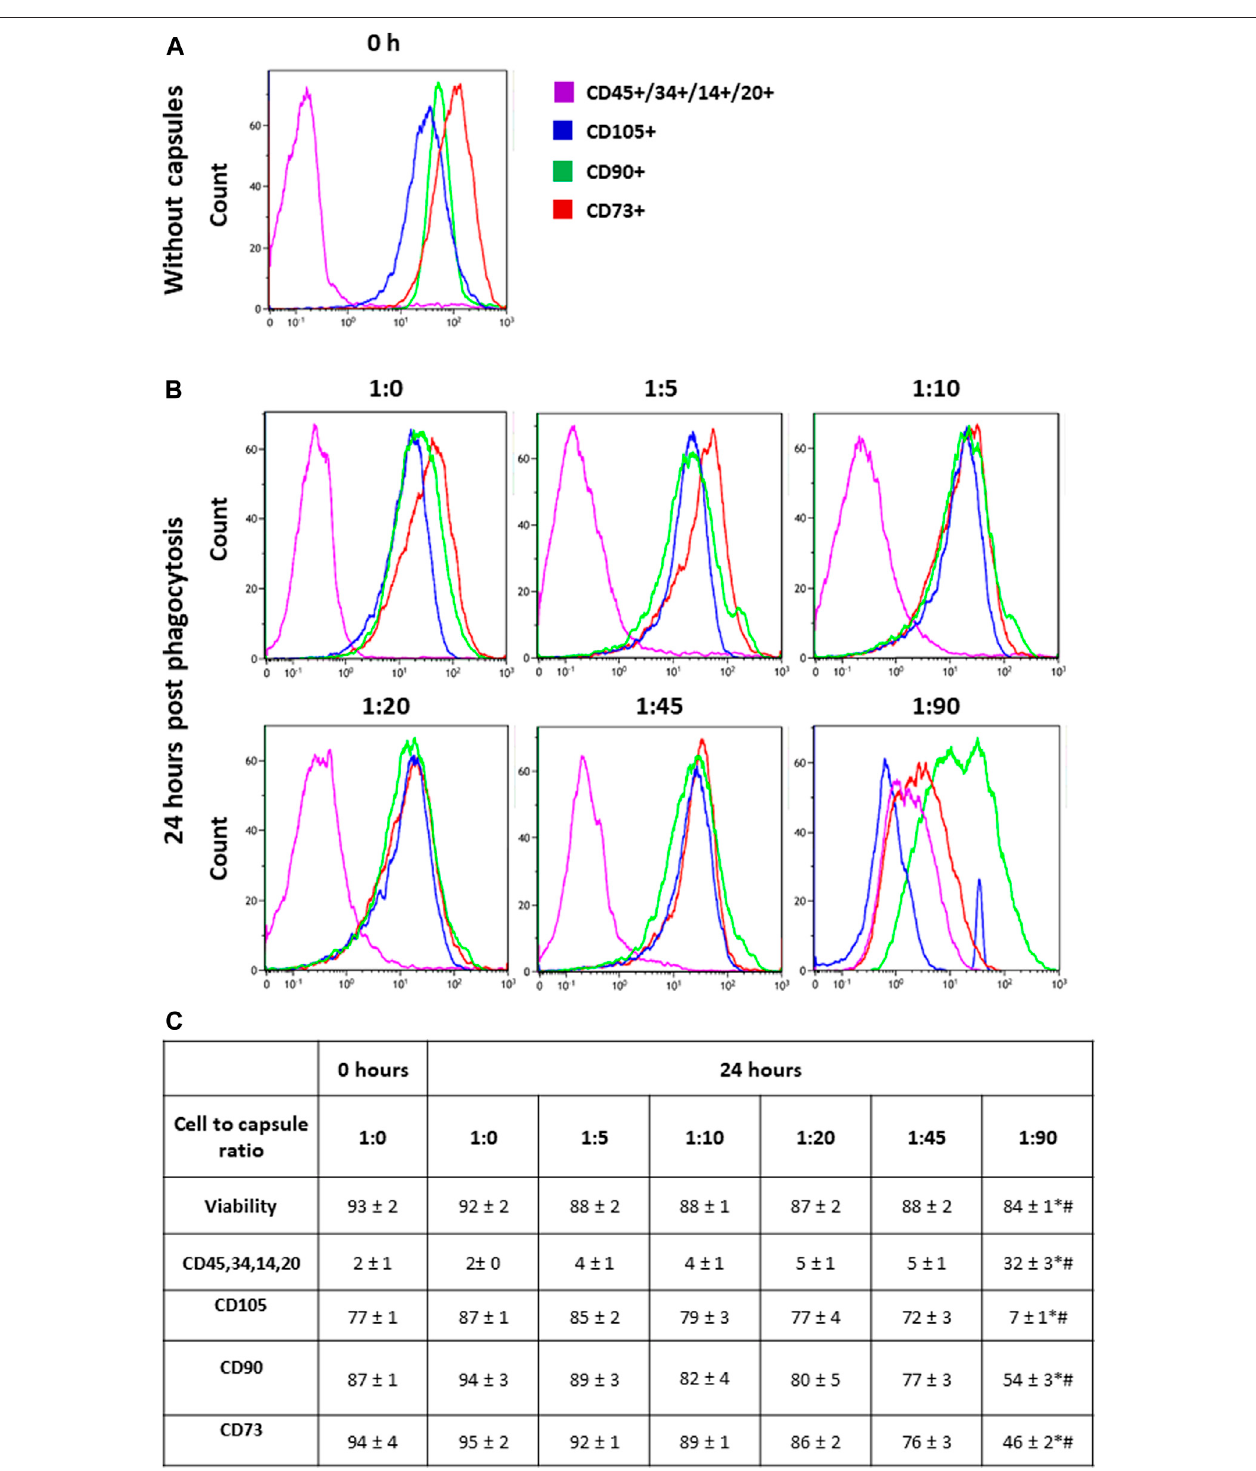
FIGURE 1 | Phenotypic switching in response to cellular loading. Following capsule phagocytosis at ratios of 1:0, 1:5, 1:10, 1:20, 1:45, and 1:90 cells were incubated for additional 24 h and then analyzed for the expression of surface markers by fl ow cytometry. Cells were gated on viability, forward, and side scatter pro fi le. Panel (A) shows the representative histogram of markers expression in hMSCs without capsules (baseline). Panel (B) shows the representative histogram of markers expression in hMSCs at 24 h post-phagocytosis at a cell/microcapsule ratio of 1:1, 1:5, 1:10, 1:20, 1:45, and 1:90. Panel (C) shows the data from three independent experiments. For each marker, the mean fl uorescence intensity was calculated and averaged across the three experiments. The values in the table are averaged mean fl uorescence intensity across the three experiments, mean + SD. * p < .05 comparison with 0 h; # p < .05 comparison with 24 h without microcapsules.